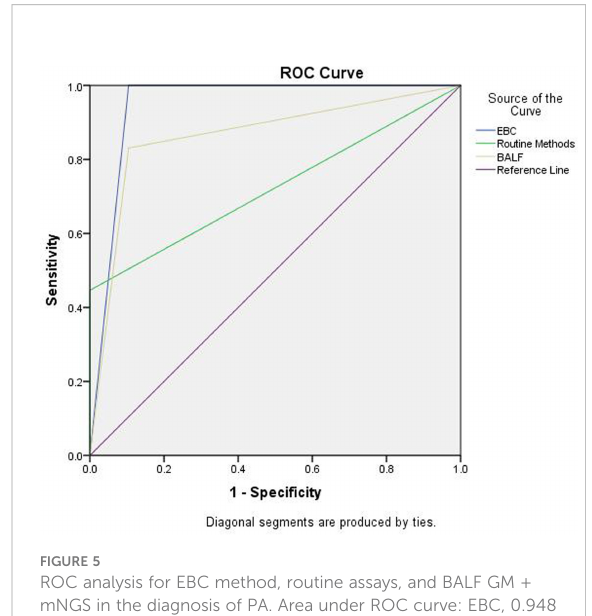
FIGURE 5 ROC analysis for EBC method, routine assays, and BALF GM + mNGS in the diagnosis of PA. Area under ROC curve: EBC, 0.948 (0.904, 0.991); routine method, 0.723 (0.634, 0.812); and BALF GM + mNGS 0.863(0.795,0.931).